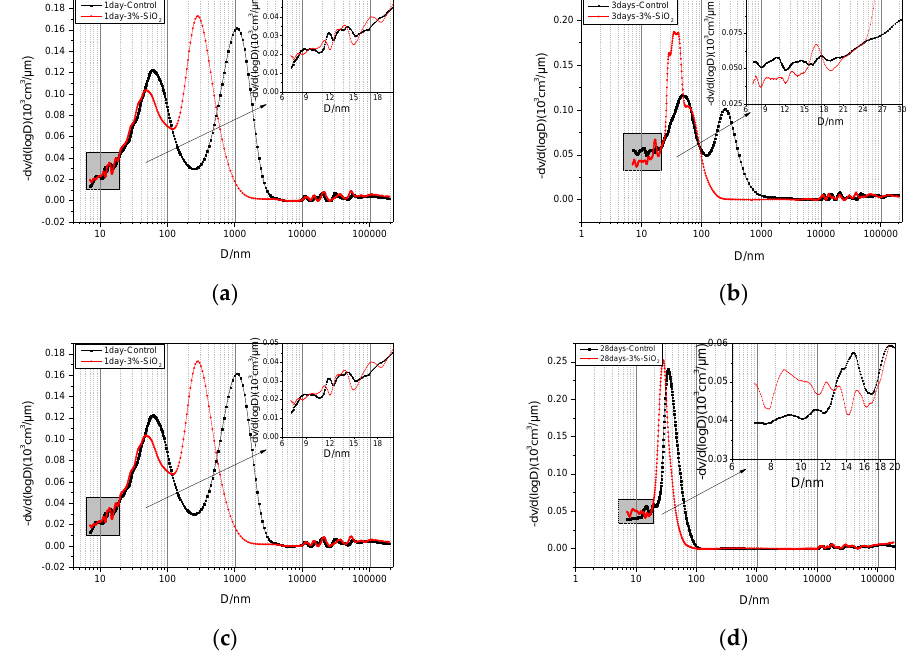
Figure 12. Pore size distribution of cement pastes with 3% or without nano-SiO 2 at different ages: ( a ) 1 day; ( b ) 3 days; ( c ) 7 days; and ( d ) 28 days.